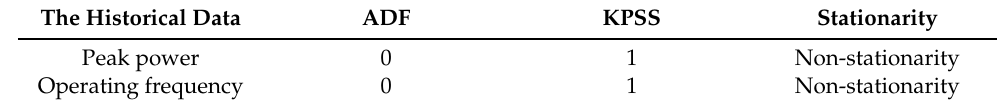
Table 2. Test results of stationarity for measurement data of the first type of degradation malfunction.